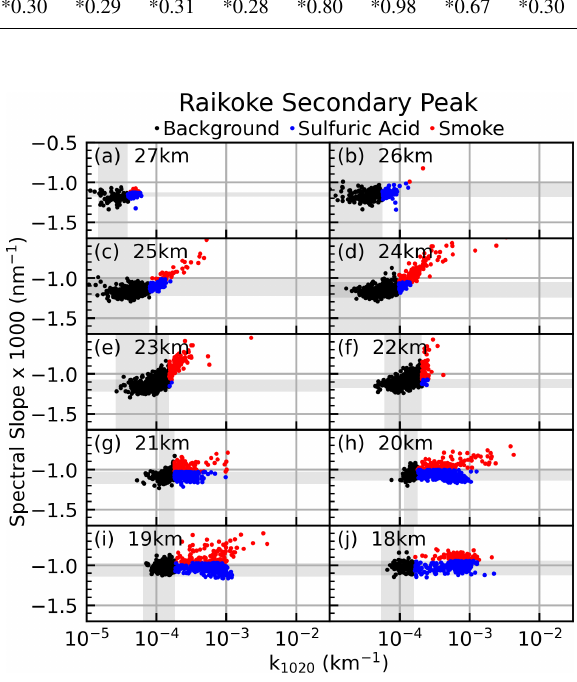
Figure 14. Same as Fig. 6, but for the Raikoke eruption. Figure 15. Same as Fig. 4, but for the elevated layer that broke off the primary Raikoke plume and continued to ascend as it moved